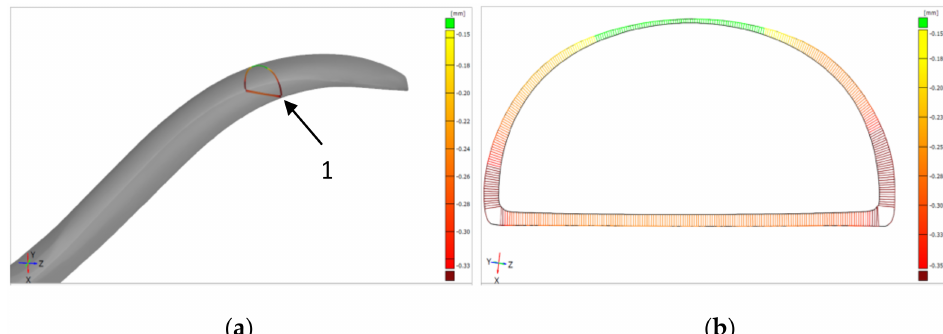
Figure 6. The idea of determining the shape deviation of the cross-section of the forceps arm: ( a ) location (1) of the cross-section along the length of the arm; ( b ) map of deviations between the reference profile (CAD profile) and the profile obtained after the grinding process.